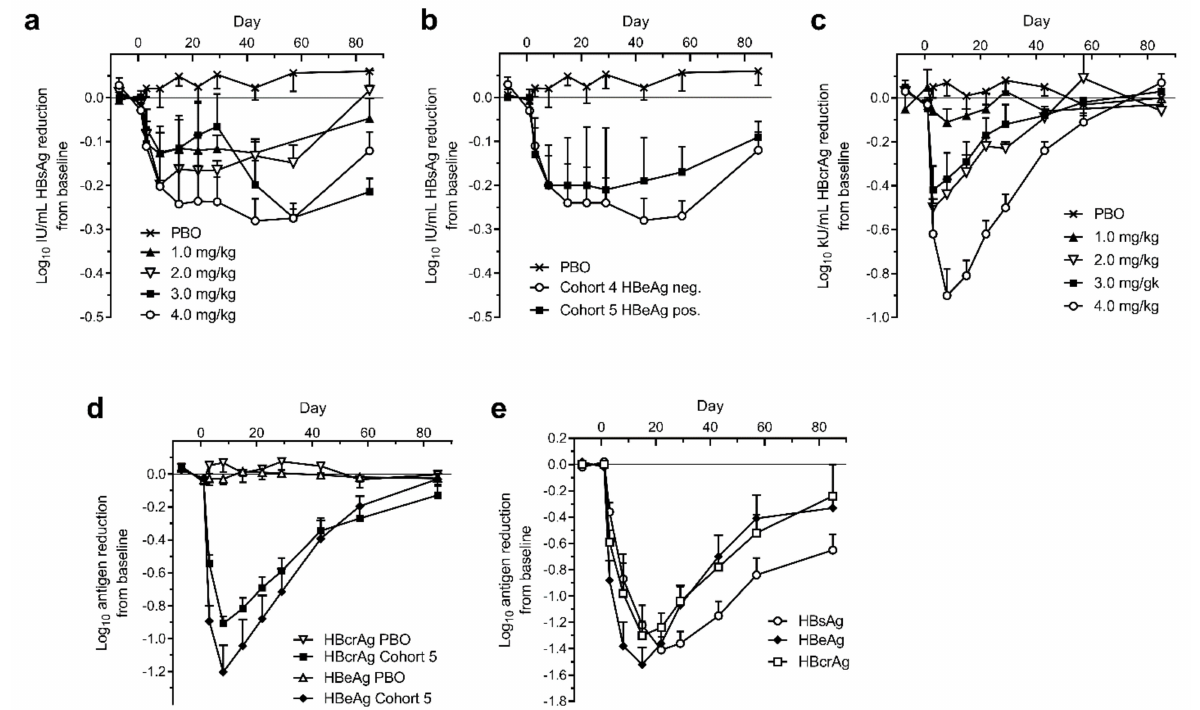
Figure 7. Serum HBsAg, HBcrAg and HBeAg in human patients treated with a single dose of ARC-520. CHB patients were given a single intravenous dose of ARC-520 (1 to 4 mg/kg) on a background of daily oral NUCs. HBsAg ( a ) or HBcrAg ( c ) reduction in CHB patients who were NUC-experienced HBeAg-negative and received single doses (1 to 4 mg/kg) (cohorts 1 to 4, n = 6). ( b ) HBsAg reduction in CHB patients who were NUC-experienced HBeAg-negative (cohort 4, n = 6) or NUC-experienced HBeAg-positive (cohort 5, n = 6) who received a single dose (4 mg/kg). ( d ) HBcrAg and HBeAg reduction in CHB patients who were NUC-experienced HBeAg-positive and received a single dose (4 mg/kg) (cohort 5, n = 6). ( e ) HBsAg, HBeAg, and HBcrAg reductions in CHB patients who were NUC-naïve HBeAg-positive and received a single dose (4 mg/kg) (cohort 7, n = 5). Reproduced from [1]. Reprinted with permission from